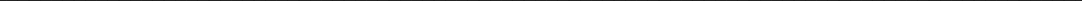
Fig. 3. Acanthodian scales from the Karksi and Novinka outcrops, Burtnieki RS, Givetian, Middle Devonian. A–F , Nostolepis gaujensis Valiukevi č ius: A, GIT 730-22, sample Karksi 90-2; B, GIT 730-23, sample Karksi 02-2; C–E, GIT 730-24, sample Karksi 02-4; F, GIT 730-25, sample Karksi 97. G–P , Ginkgolepis tenericostatus n. sp.: G, GIT 730-37, sample Karksi 15-5; H, I, GIT 730-38, sample Karksi 15-8; J, K, GIT 730-39, sample Karksi 15-10; L, GIT 730-36, sample Karksi 15-8; M, PM SPbSU 86-56, sample Novinka; N–P, GIT 730-40, sample Karksi 15-10. Q , Acanthodes ? sp., GIT 730-47, sample Karksi 15-7. R , Ptychodictyon sulcatum Gross, GIT 730-43, sample Karksi 02-2. S , Cheiracanthus brevicostatus Gross, GIT 730-45, sample Karksi 97. A–H, J, L, N, Q–S, top view; I, lateral view; K, bottom view; M, anterolateral view; O, P, lateral view of the crown and the neck surfaces. Scale bars = 100 μ